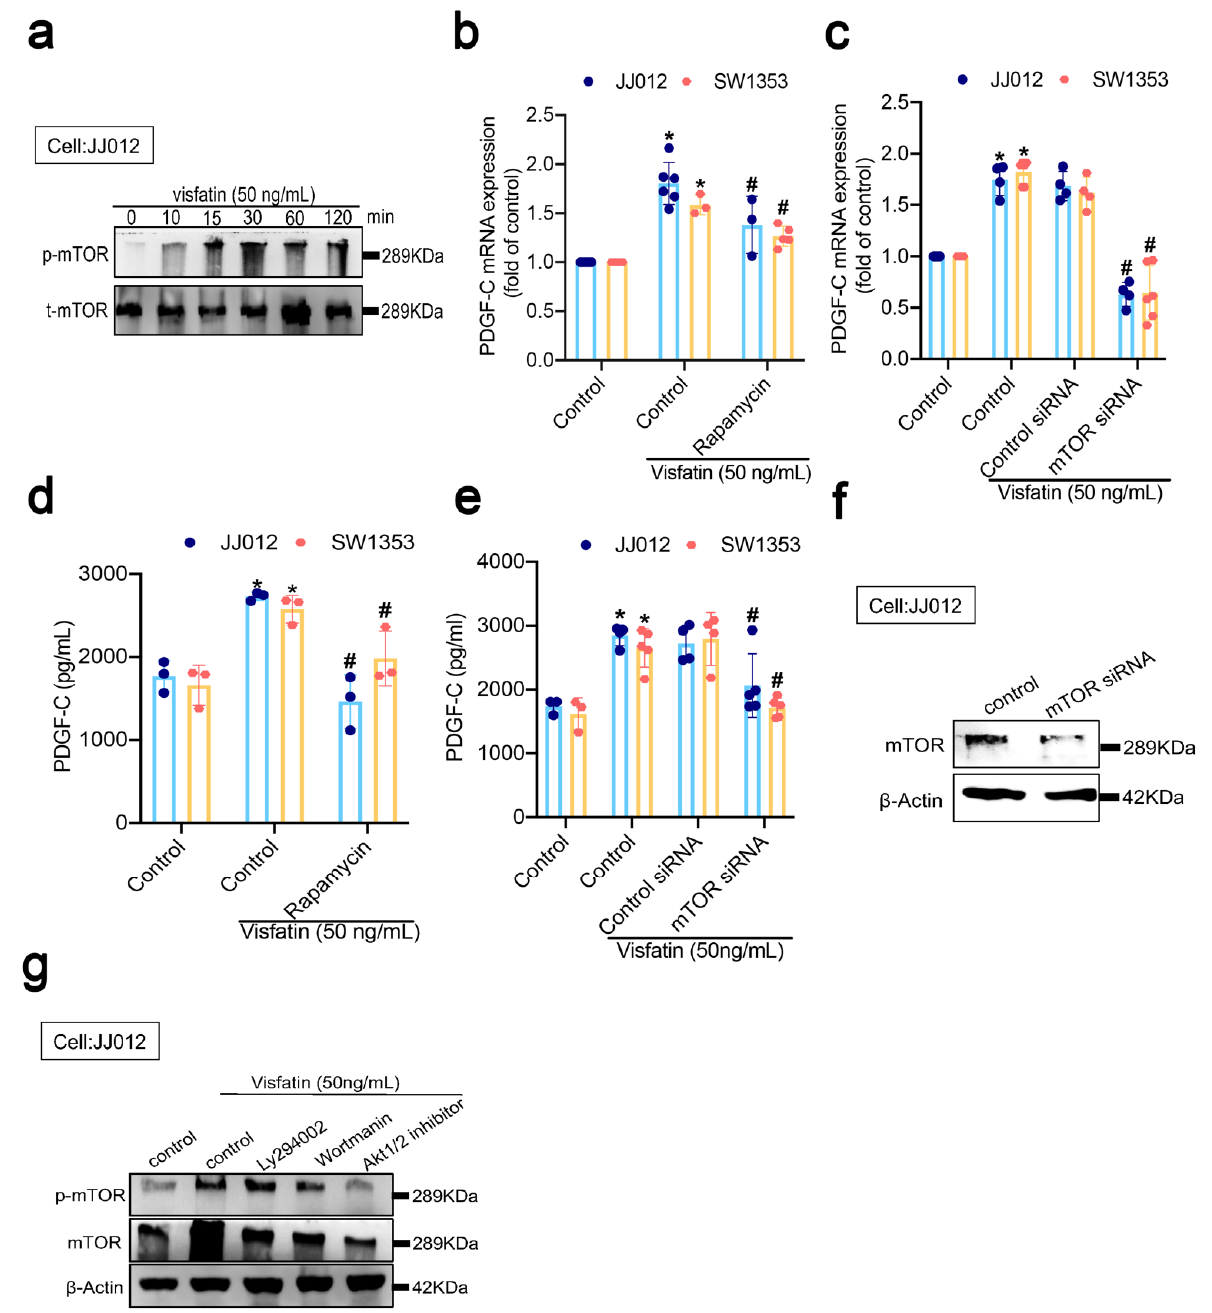
Figure 4. mTOR regulated visfatin-induced stimulation of PDGF-C expression in human chondrosarcomas. ( a ) JJ012 cells were incubated with visfatin for the indicated time intervals and mTOR phosphorylation was determined by Western blot; ( b – e ) JJ012 and SW1353 cells were pretreated with rapamycin (10 μ M) or transfected with an mTOR siRNA for 30 min, then treated with visfatin for 24 h. PDGF-C expression was determined by q-PCR and ELISA; ( f ) JJ012 cells were transfected with mTOR siRNA. mTOR expression was examined by Western blot; ( g ) JJ012 cells were pretreated with Ly294002, wortmannin, or an AKT1/2 inhibitor for 15 min, then stimulated with visfatin for 30 min and mTOR phosphorylation was measured. Quantitative results are expressed as means ± SD. Compared with the control group, * p -values < 0.05; compared with the visfatin-treated group, # p -values < 0.05.